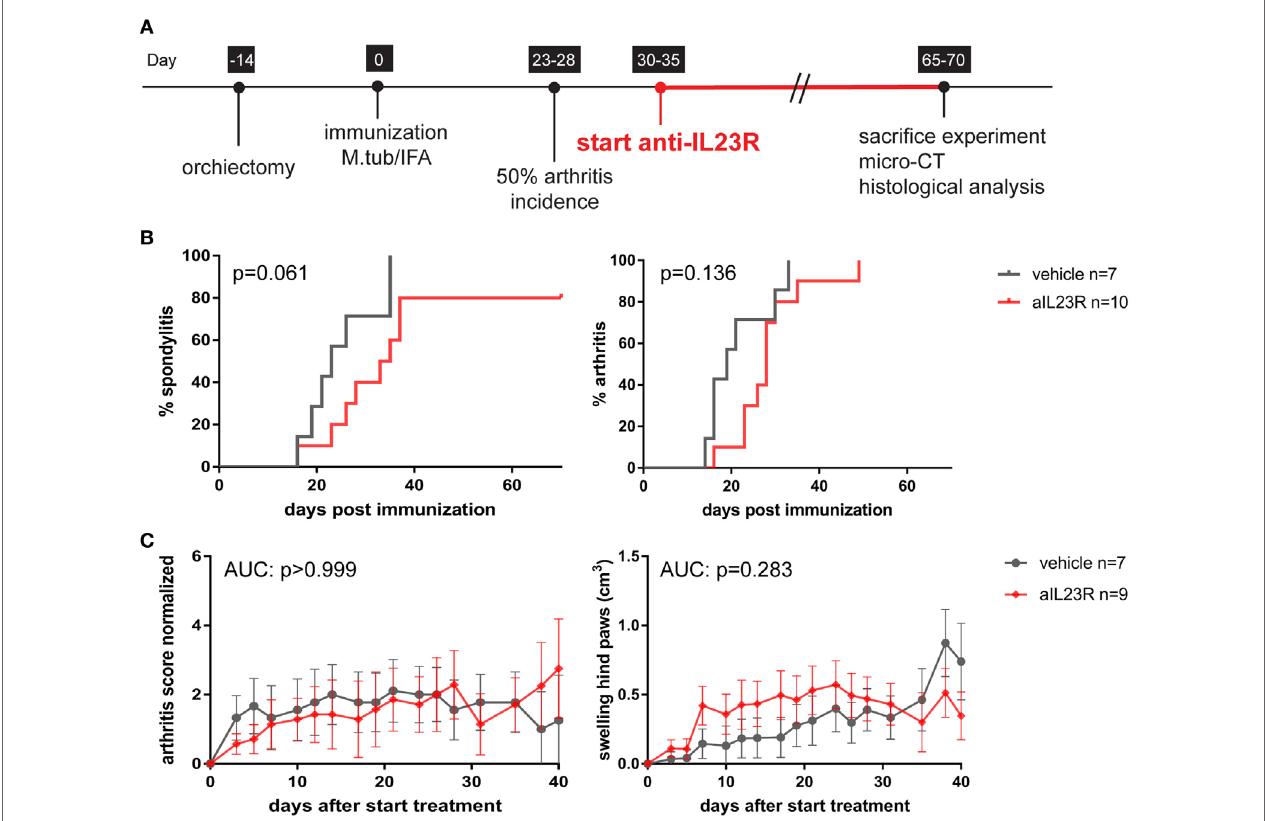
FigUre 2 | Therapeutic treatment with anti-IL23R does not affect established spondylitis and arthritis. (a) Timeline of the experiment where HLA-B27 tg rats were immunized and therapeutically treated with anti-IL23R or vehicle for 5 weeks ( n = 10 and n = 7 per group, respectively). (B) Spondylitis and arthritis incidence (survival analysis). (c) Arthritis severity as measured by arthritis score and swelling of the hind paws (data are mean ±